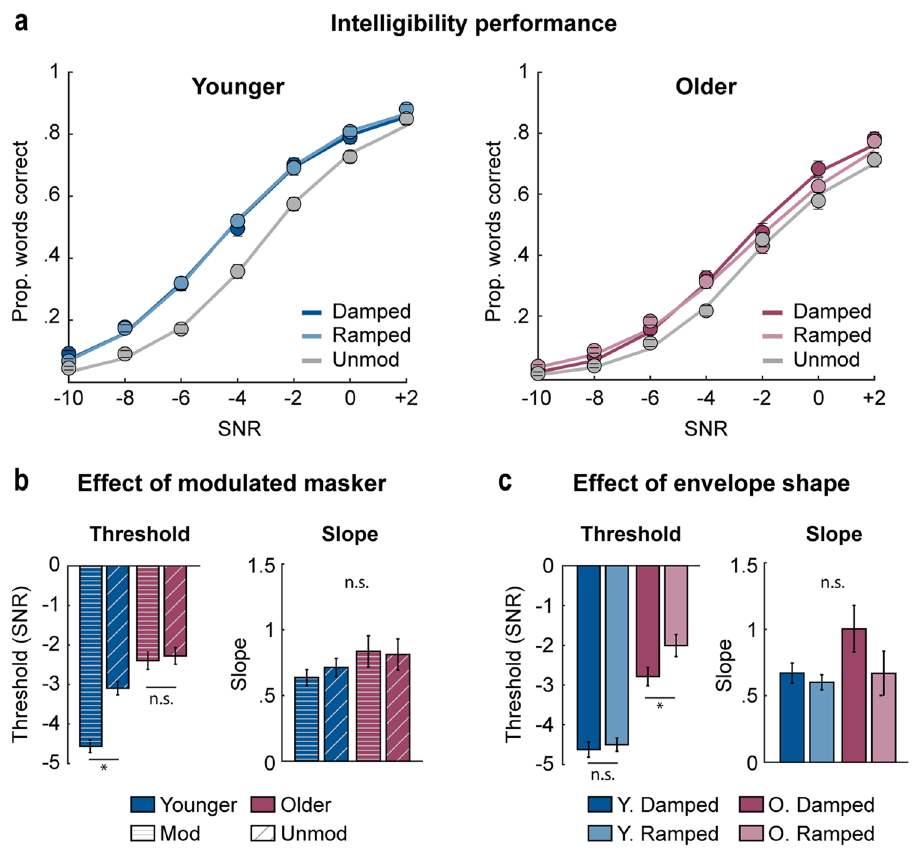
Figure 2. Intelligibility results for Experiment 1. ( a ) Mean proportion of correctly reported words plotted as a function of SNR (− 10, − 8, − 6, − 4, − 2, 0, + 2 dB) for younger (left) and older adults (right), and for envelope conditions (damped, ramped, unmodulated). Colored lines correspond to a logistic function fit to the proportion of correct words reported. ( b ) Mean threshold (left) and slope (right) coefficients from logistic function fits are plotted for the different modulation types (modulated [averaged across ramped and damped], unmodulated) and age groups (younger, older). ( c ) Mean threshold (left) and slope (right) coefficients are plotted for the different masker envelope shapes (damped, ramped) and age groups (younger, older). Error bars reflect the standard error of the mean. *p <